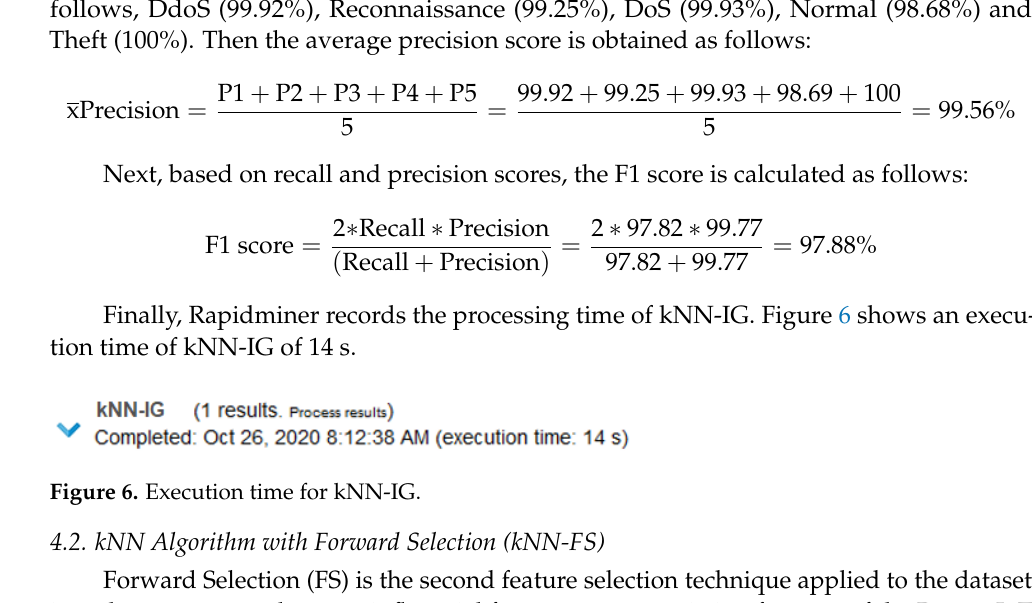
Figure 7. Forward Selection. Table 4. Reduced features by Forward Table 4. Reduced features by Forward Selection.